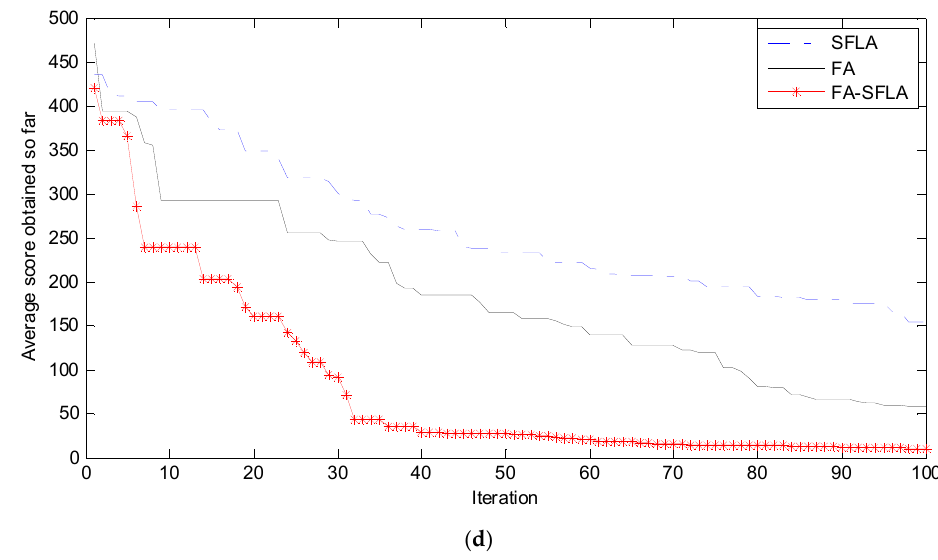
Figure 5. Simulation comparison curves of FA-SFLA. ( a ) Sphere function; ( b ) Griewank function; ( c ) Rosenbrock function; ( d ) Rastrigin function.